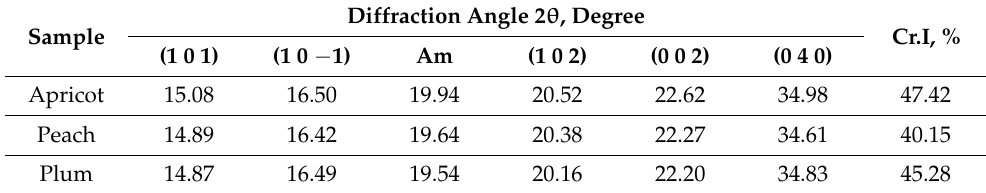
Table 3. The reflection positions of crystal planes and amorphous cellulose forms for the studied wood